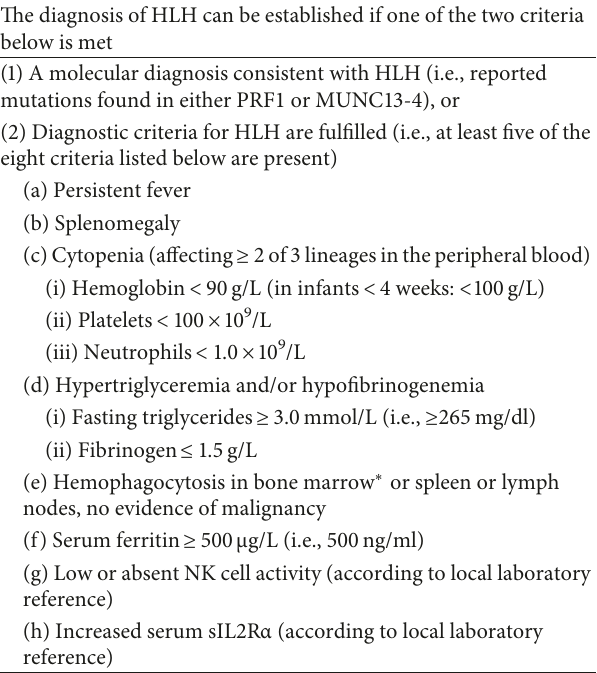
Table 1: Diagnostic criteria for macrophage activation syndrome: HLH-2004—revised diagnostic guidelines for HLH10.